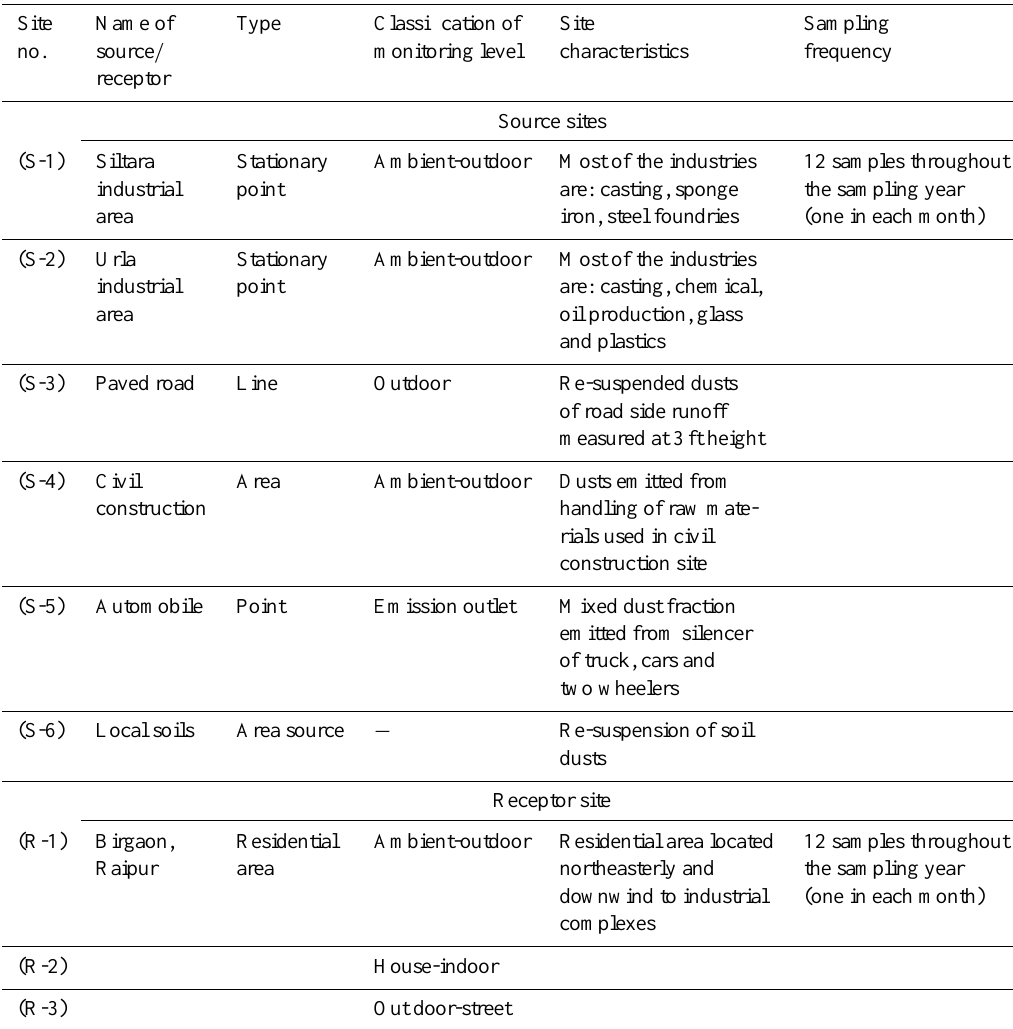
Table 1. Identification and grouping of defined sources and receptor in the study